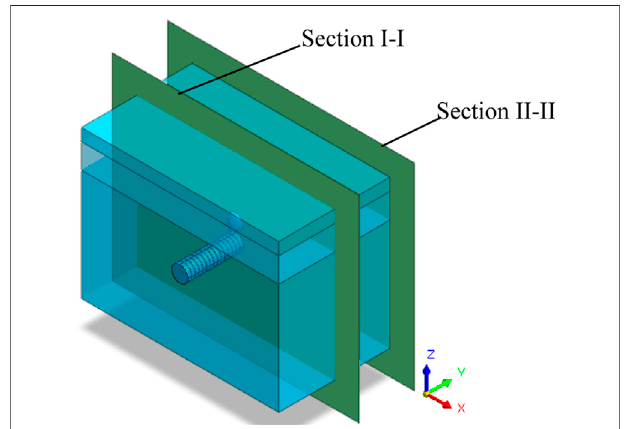
FIGURE 11 | Section I-I and section II-II distribution schematic